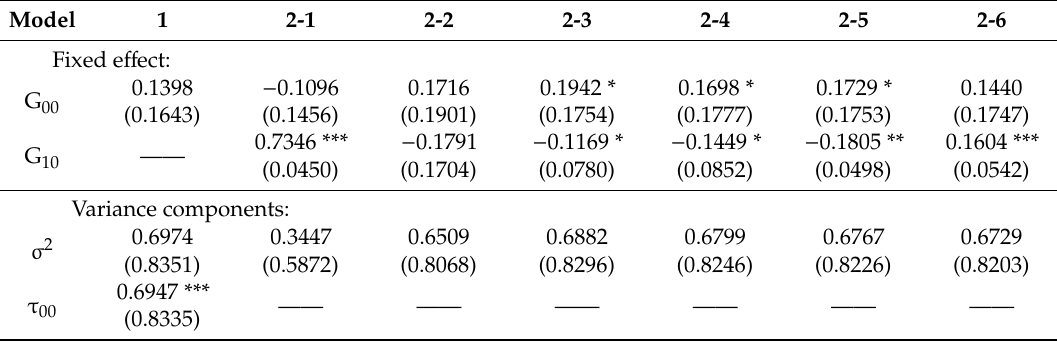
Table 4. The estimation of parameters and variance components (with standard errors) for Model 1 and Model 2 (Note: *, **, and *** denote the significance level at 10%, 5%, and 1%,